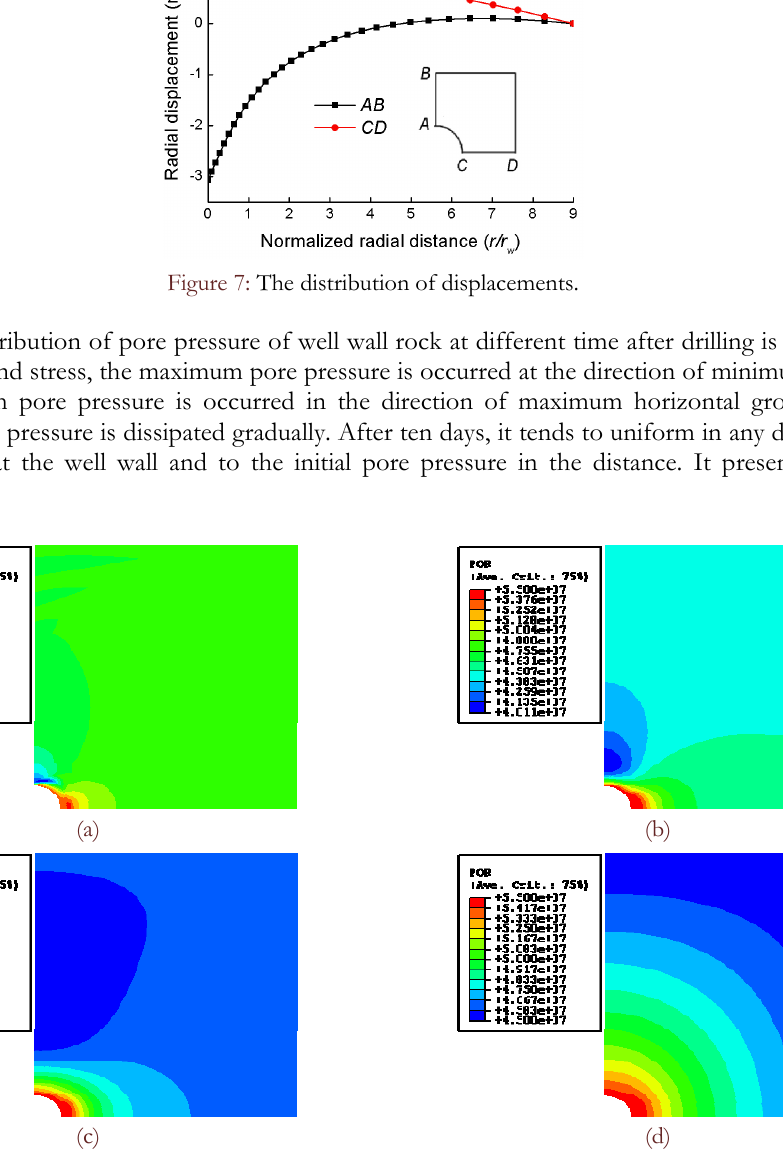
Figure 8: The pore pressure at different time (unit: Pa). (a) 100s; (b) 1h; (c) 10h; (d)